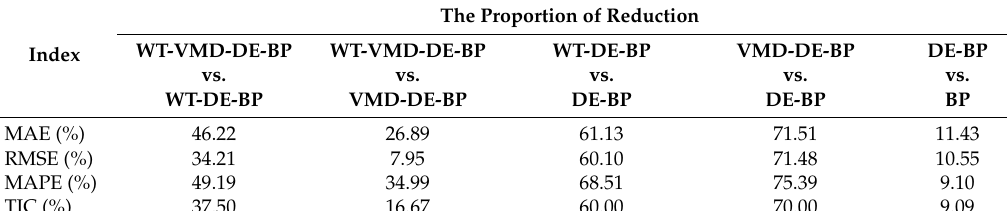
Figure 18. The ultimate forecast results of different models (Tianjin).